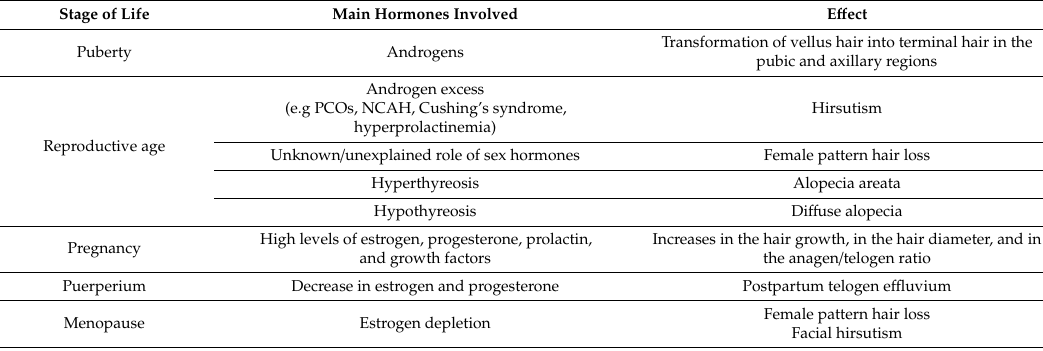
Table 1. Influence of hormones on the hair cycle in di ff erent stages of female